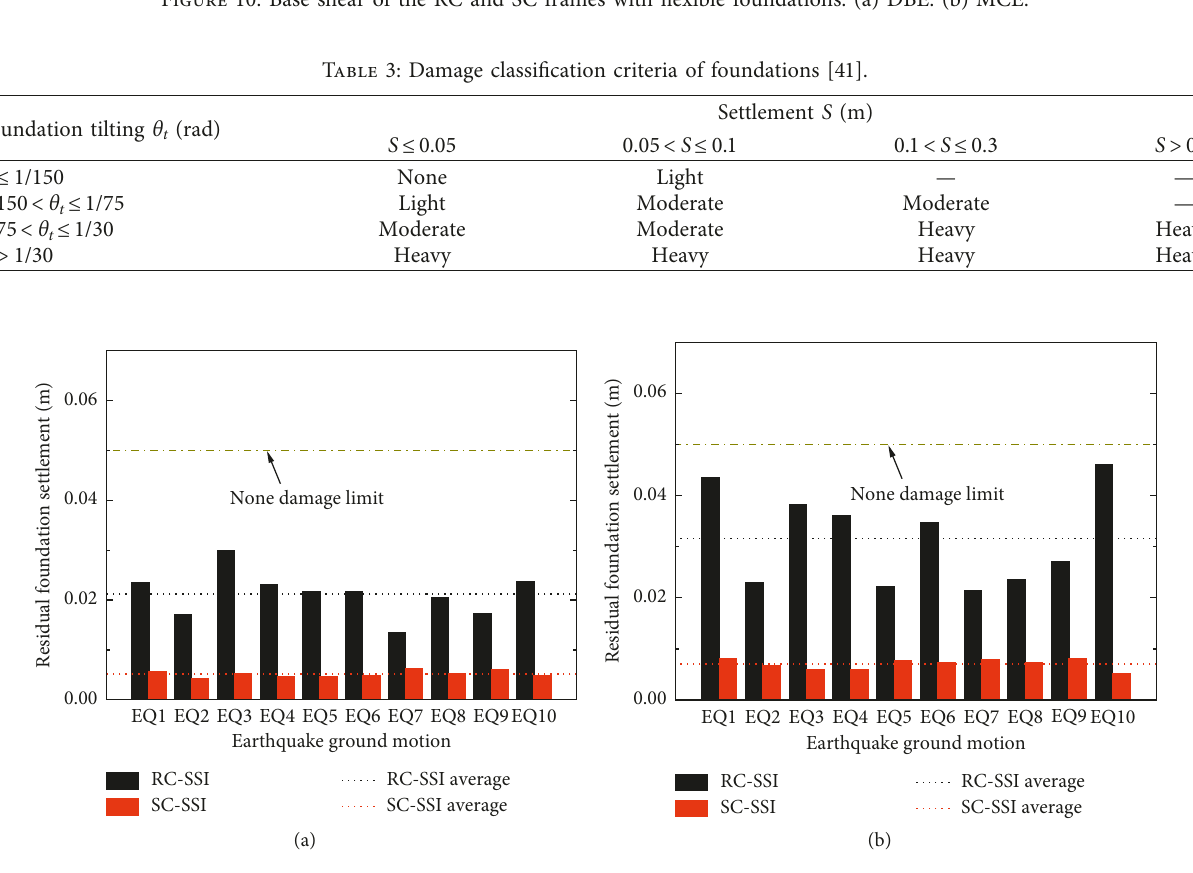
Figure 11: Residual foundation settlements of the RC-SSI and SC-SSI frames. (a) DBE. (b)